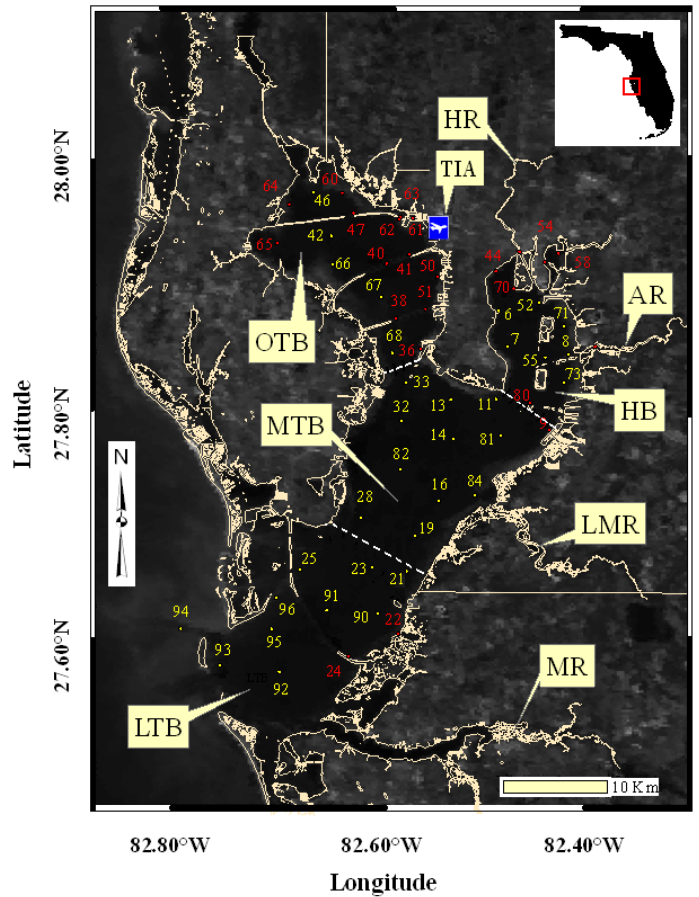
Figure 1. NASA MODIS MOD09GQ image of Tampa Bay showing the 56 stations monitored by the Environmental Protection Commission of Hillsborough County (EPCEC), the four main sub-regions and the major tributaries. Stations marked in yellow were used in this study while those in red were excluded for not meeting the criteria (see